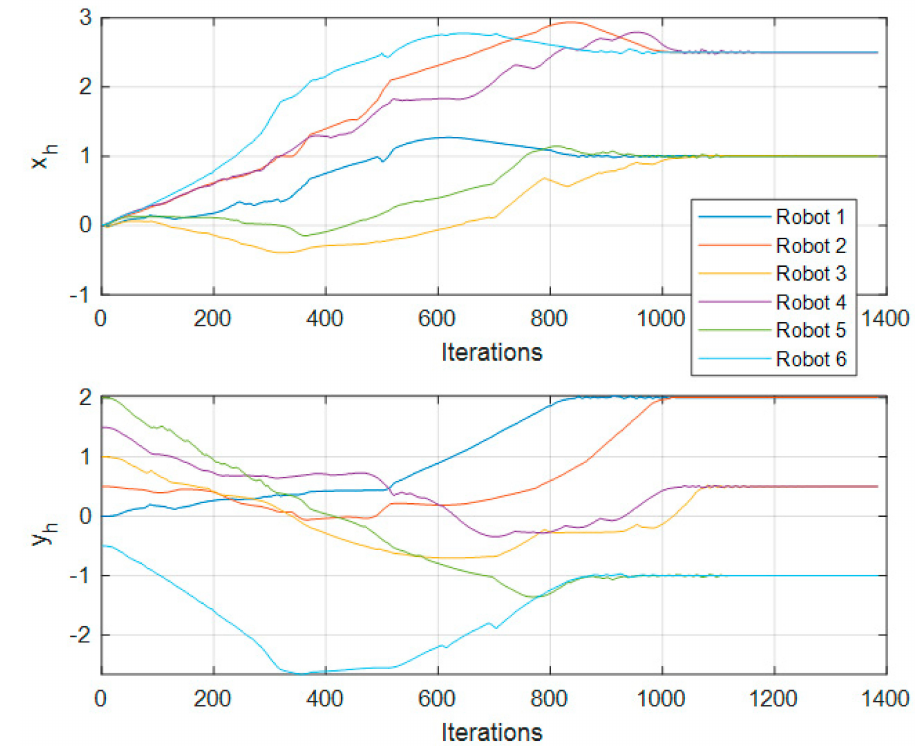
Figure 20. Trajectories along iterations in the 6-robot real-world test.